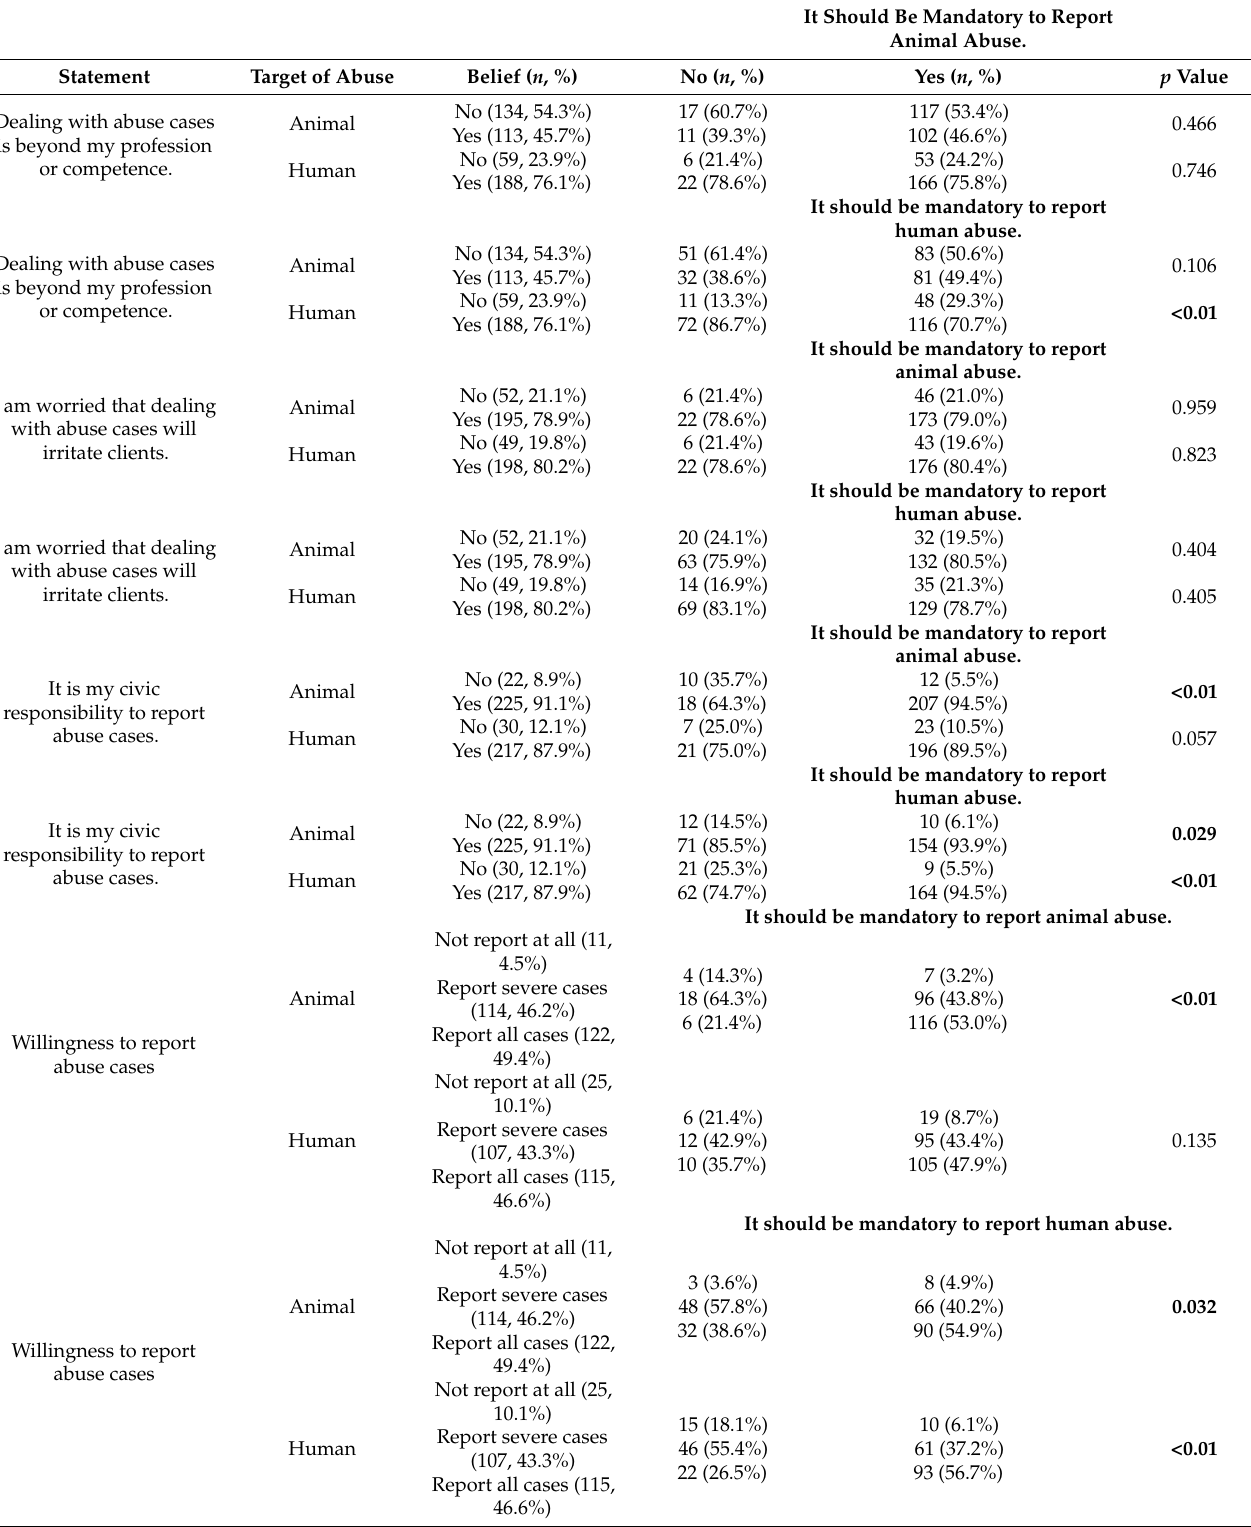
Table 6. Comparisons between respondents who stated that it should be mandatory to report abuse cases and the consequences that they worried about and their attitude toward reporting abuse